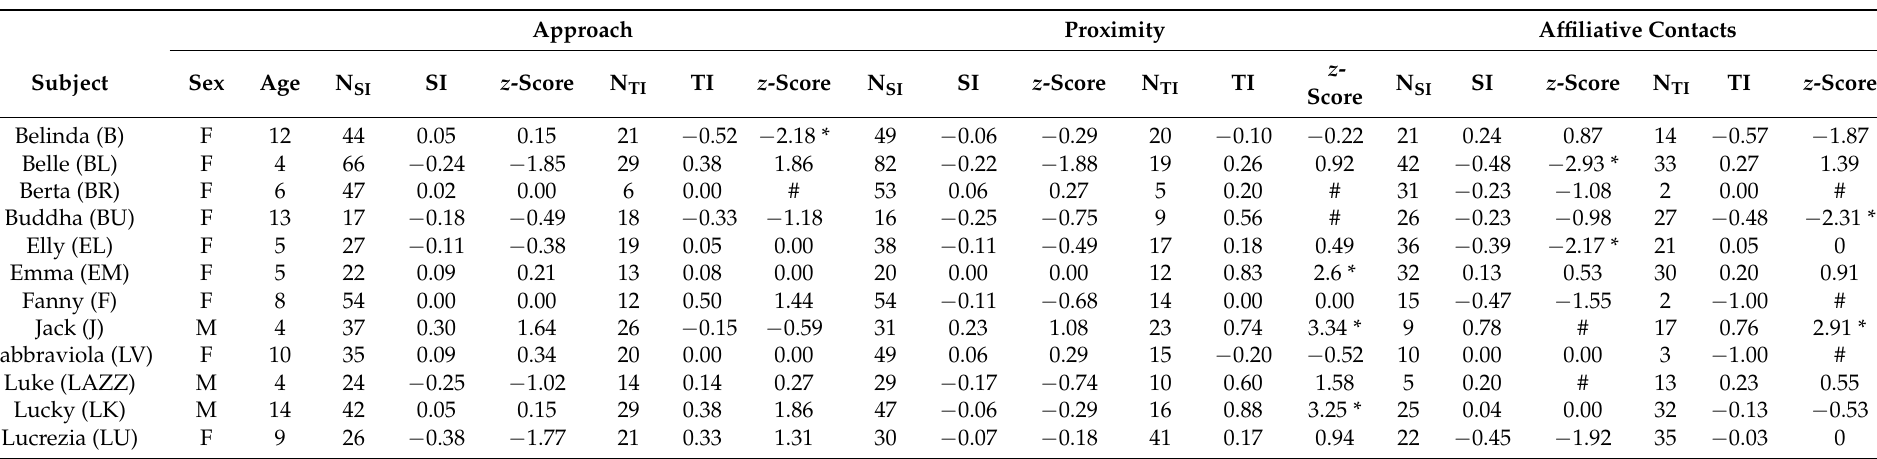
Table 1. Side and transversality preference during different social interactions. For each macaque, the table reports name, sex (F = female; M = male) and age (years at the time of data collection). For each social interaction (approach, proximity and affiliative contacts), the table reports the total number of bouts collected to calculate both SI (N SI ) and TI (N TI ), the SI (Side Index), the TI (Transversality Index) and the relative z -score. Asterisks indicate subjects with a significant laterality preference (right/front: z -score ≥ 1.96 or left/rear: z -score ≤ − 1.96). # Insufficient number of